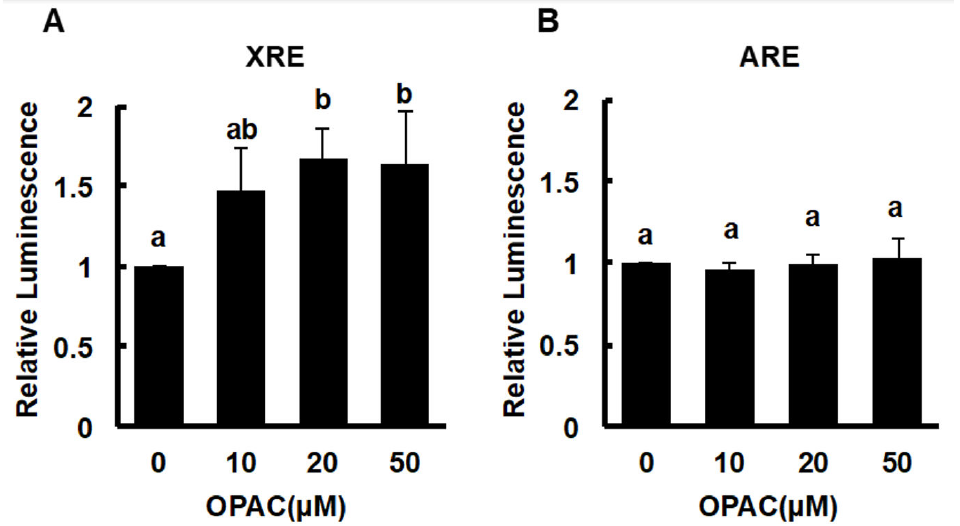
Figure 4. Modulating effects of OPAC on the transcriptional activities of AhR ( A ) and Nrf2 ( B ). HaCaT cells stably expressing the XRE- or ARE-reporter gene (XRE-NLuc::HaCaT or ARE-NLuc::HaCaT) were treated with OPAC for 6 h, and the reporter luciferase expression was measured as luminescence by a microplate luminometer. All values are expressed as means ± SD of three separate experiments. The different letters above the bars indicate significant differences among the treatments for each condition ( p <